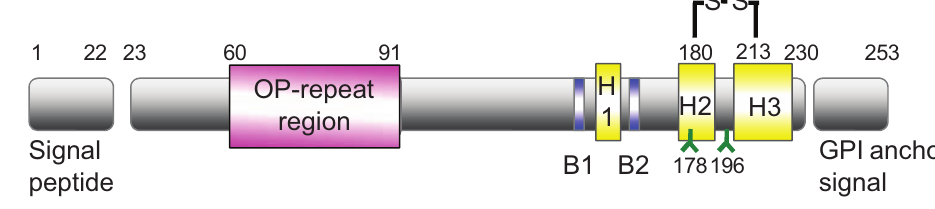
Figure 1. Domain structure of human prion protein